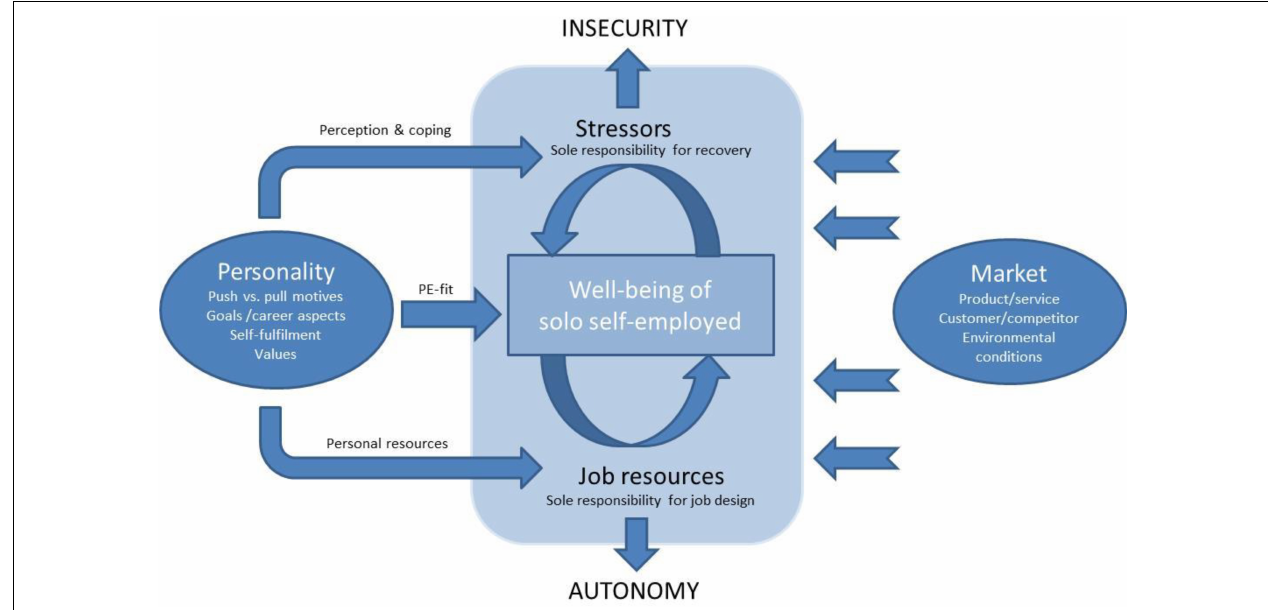
FIGURE 1 | A work-psychological stress model for small business